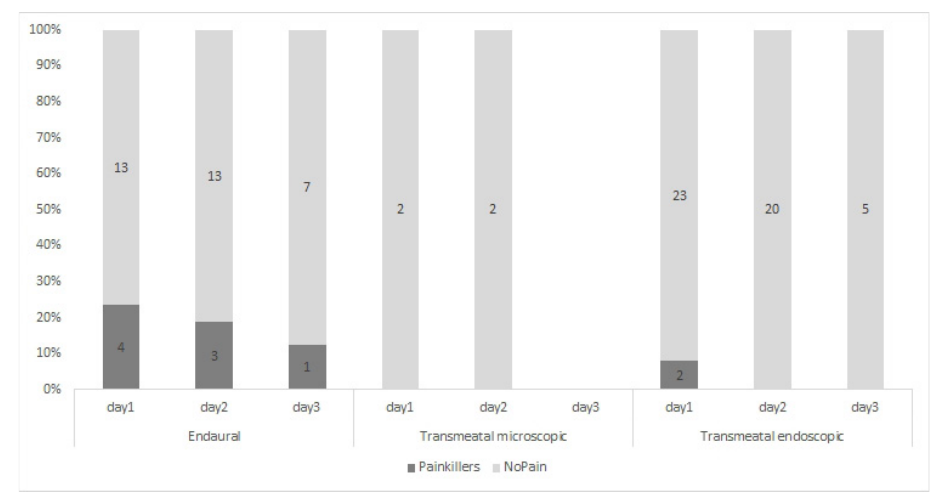
Fig. 4. A consumption of analgetics after endoscopic and microscopic ear surgeries in the recon- struction group only. The graph reports the number of patients taking any painkiller versus patients not requiring any pain control.